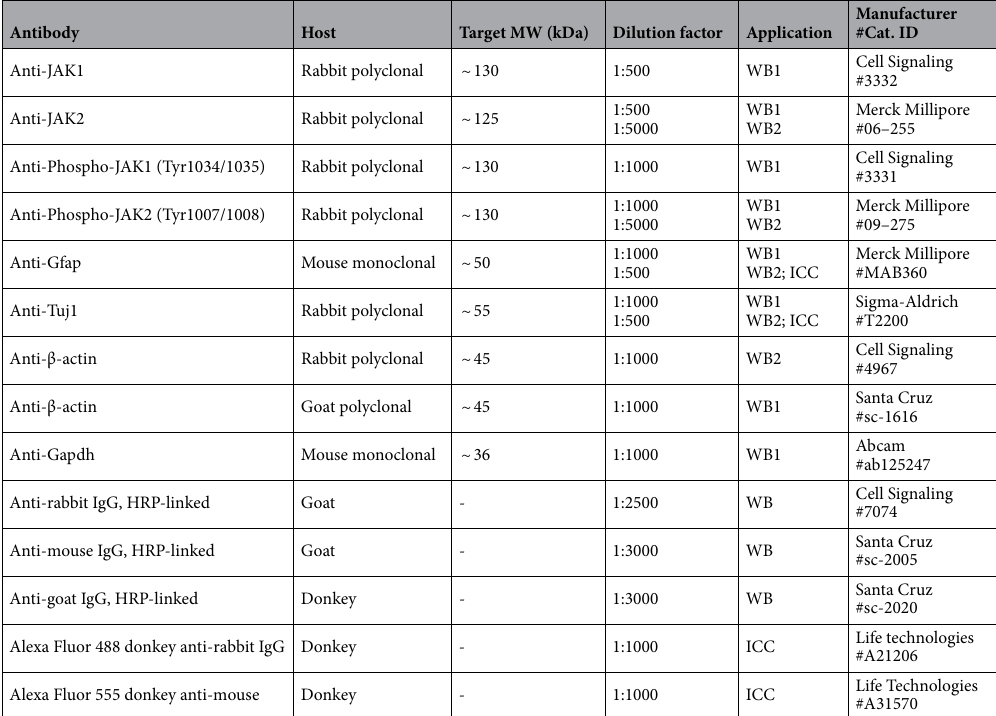
Table 1. List of antibodies for western blot or immunocytochemistry. WB1 refers to immunoblotting for brain tissue lysates from P1.5 pups (Fig. 2); WB2 refers to immunoblotting for protein lysates from differentiating neurospheres (Fig. 3); ICC refers to